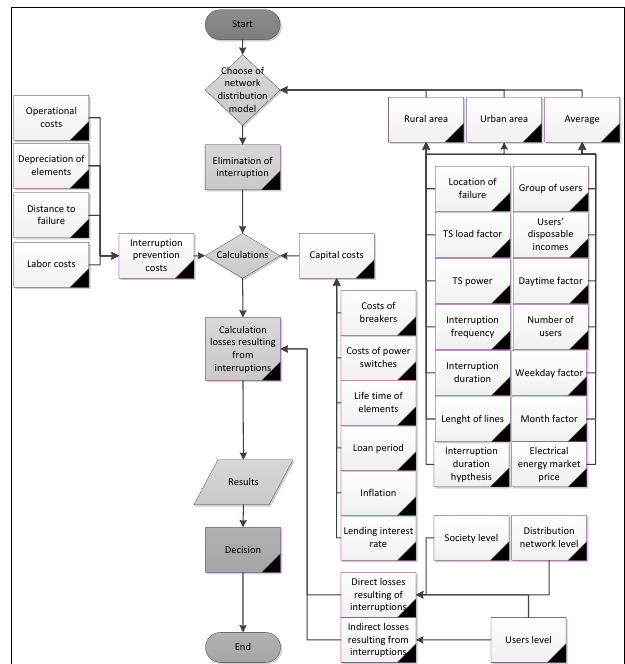
Fig. 2. Multi–criteria analysis of calculation of electric supply reliability and losses resulted from